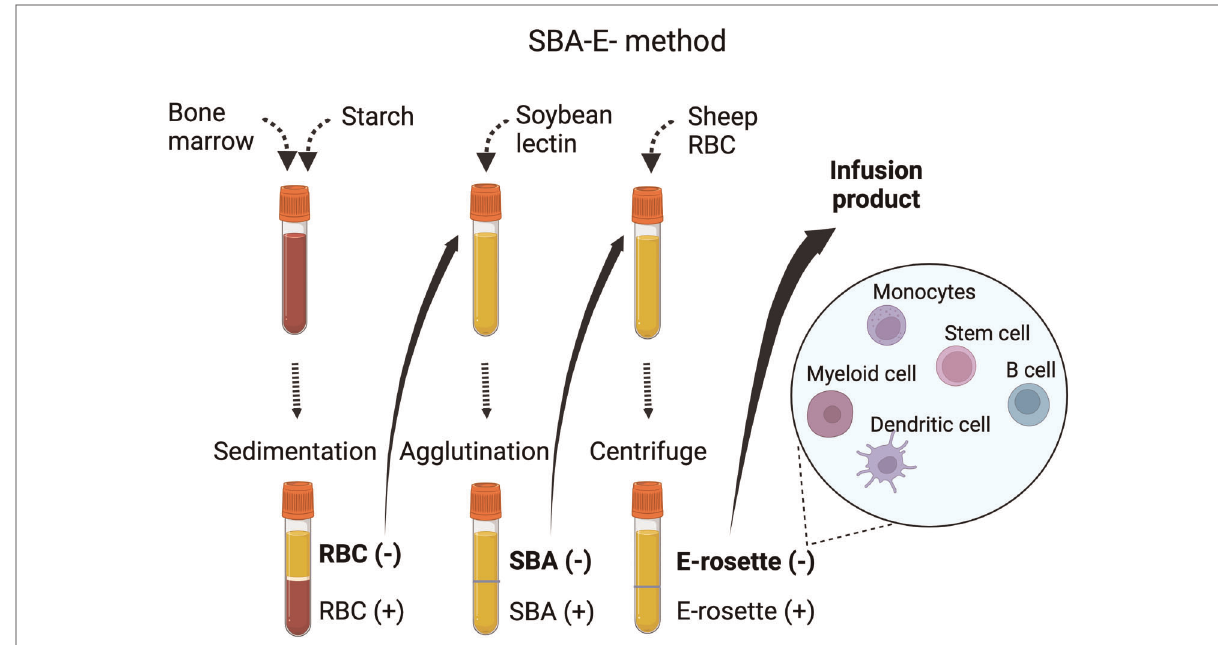
FIGURE 1 Soybean lectin agglutination and E-rosette (SBA-E-) method.There are four main steps in the procedure, (1) Filtered bone marrow is separated over hetastarch and the leukocyte-rich plasma (RBC-) is collected. (2) Leukocyte-rich plasma is mixed with soybean lectin, allowed to agglutinate and then settled through 5% albumin. (3) The unagglutinated (SBA-negative) population is mixed with sheep RBCs to allow R-rosette formation with T cells. After centrifugation over fi coll-hypaque, the supernatant (R-rosette negative) is collected. A fi nal separation removes the trace of residual T cells in the SBA-E- fraction by separation of cells forming E-rosettes with neuraminidase-treated sheep RBCs.Abbreviation: SBA-E-, soybean agglutination negative and E-rosette negative; RBC, red blood